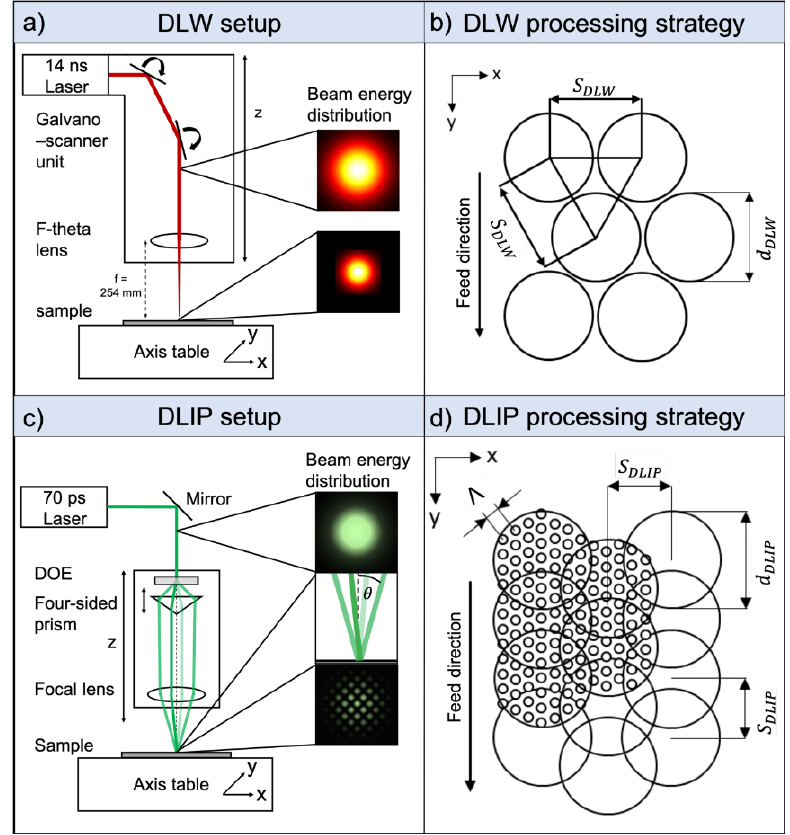
Figure 1. Schematic drawing of the used DLW setup, the local laser beam energy distribution ( a ) and the corresponding processing strategy ( b ). The used DLIP setup including the optical elements and the four-beam interference energy distribution ( c ) and the DLIP processing strategy depicting the dot-like interference pattern in the focal zone ( d ) are shown.